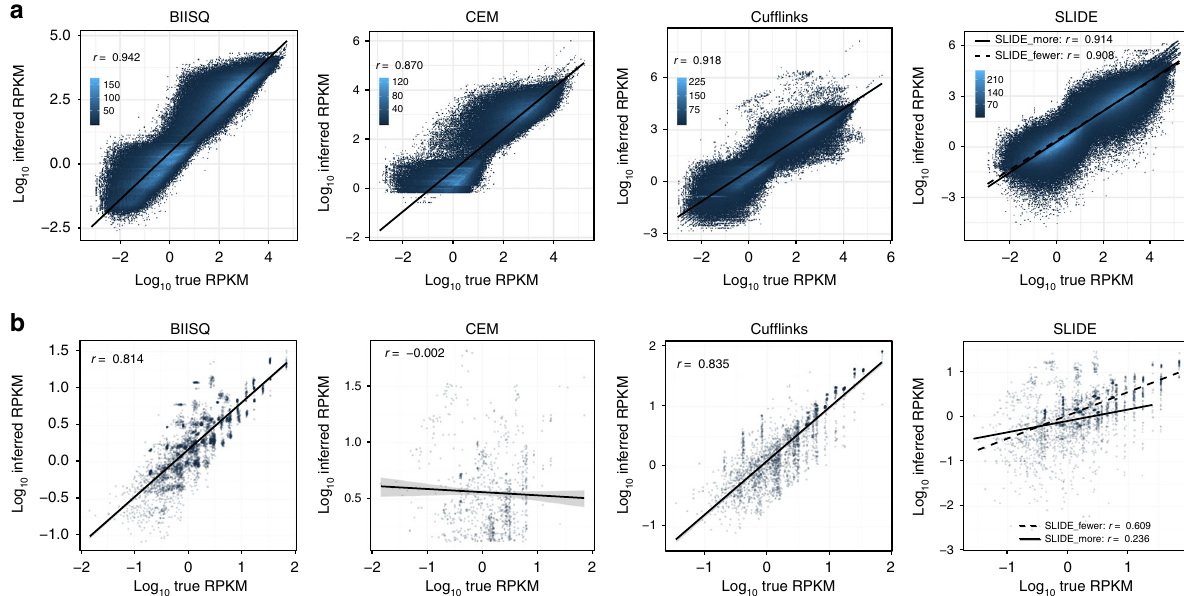
Fig. 3 Isoform quanti fi cation accuracy. Correlation between true RPKM and inferred RPKM for a BEERS-simulated data and b Iso-Seq-simulated data. Spearman correlation coef fi cients for results from BIISQ , CEM, Cuf fl inks, SLIDE_more, and SLIDE_fewer were a 0.942, 0.870, 0.918, 0.914, and 0.908, respectively, for BEERS-simulated data and b 0.814, − 0.002, 0.835, 0.609, and 0.236, respectively, for simulated short-read data from Iso-Seq reads. A regression line represents the best linear fi t for each method to the expression